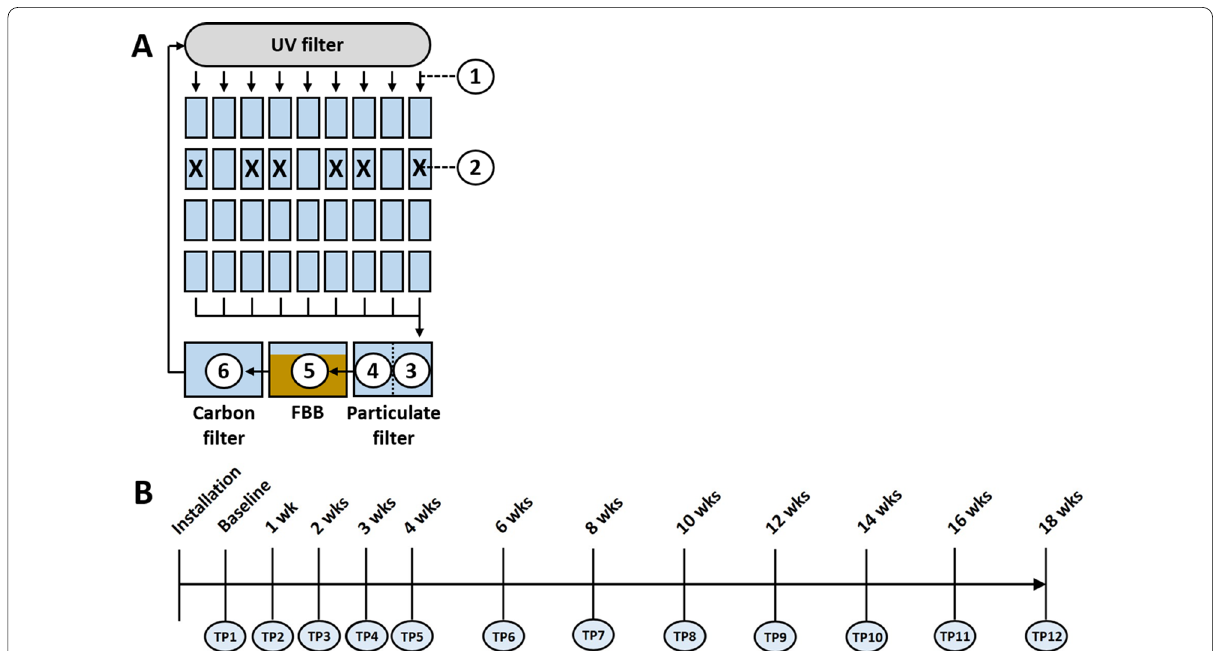
Fig. 1 Schematic diagram of the recirculating system, and the sampled sites including post-UV disinfection water (1), tank water from six different tanks in which fish were introduced following collection of baseline samples, denoted by X (2), pre-particulate filter water (3), post-particulate filter water (4), the fluidized bed biofilter (FBB) (5), and carbon filter water (6) ( A ), and timeline showing the time-points (TP) at which samples were collected from each site, in quadruplicate ( B